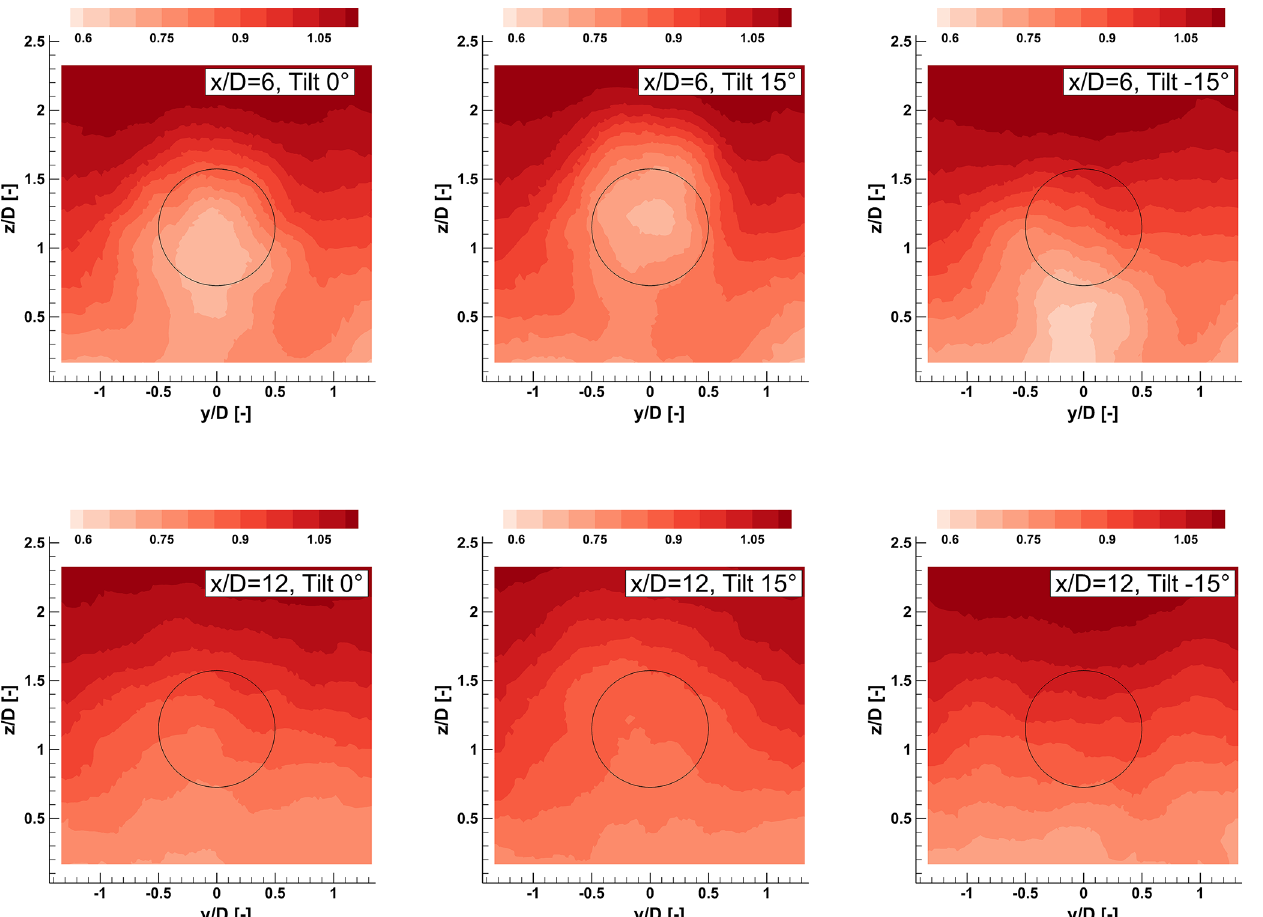
Figure 5. Contours of normalized streamwise velocity u/U hub on yz cross-planes (orthogonal to the flow) for two downstream distances and three rotor tilt angles. The black circle denotes the rotor disk